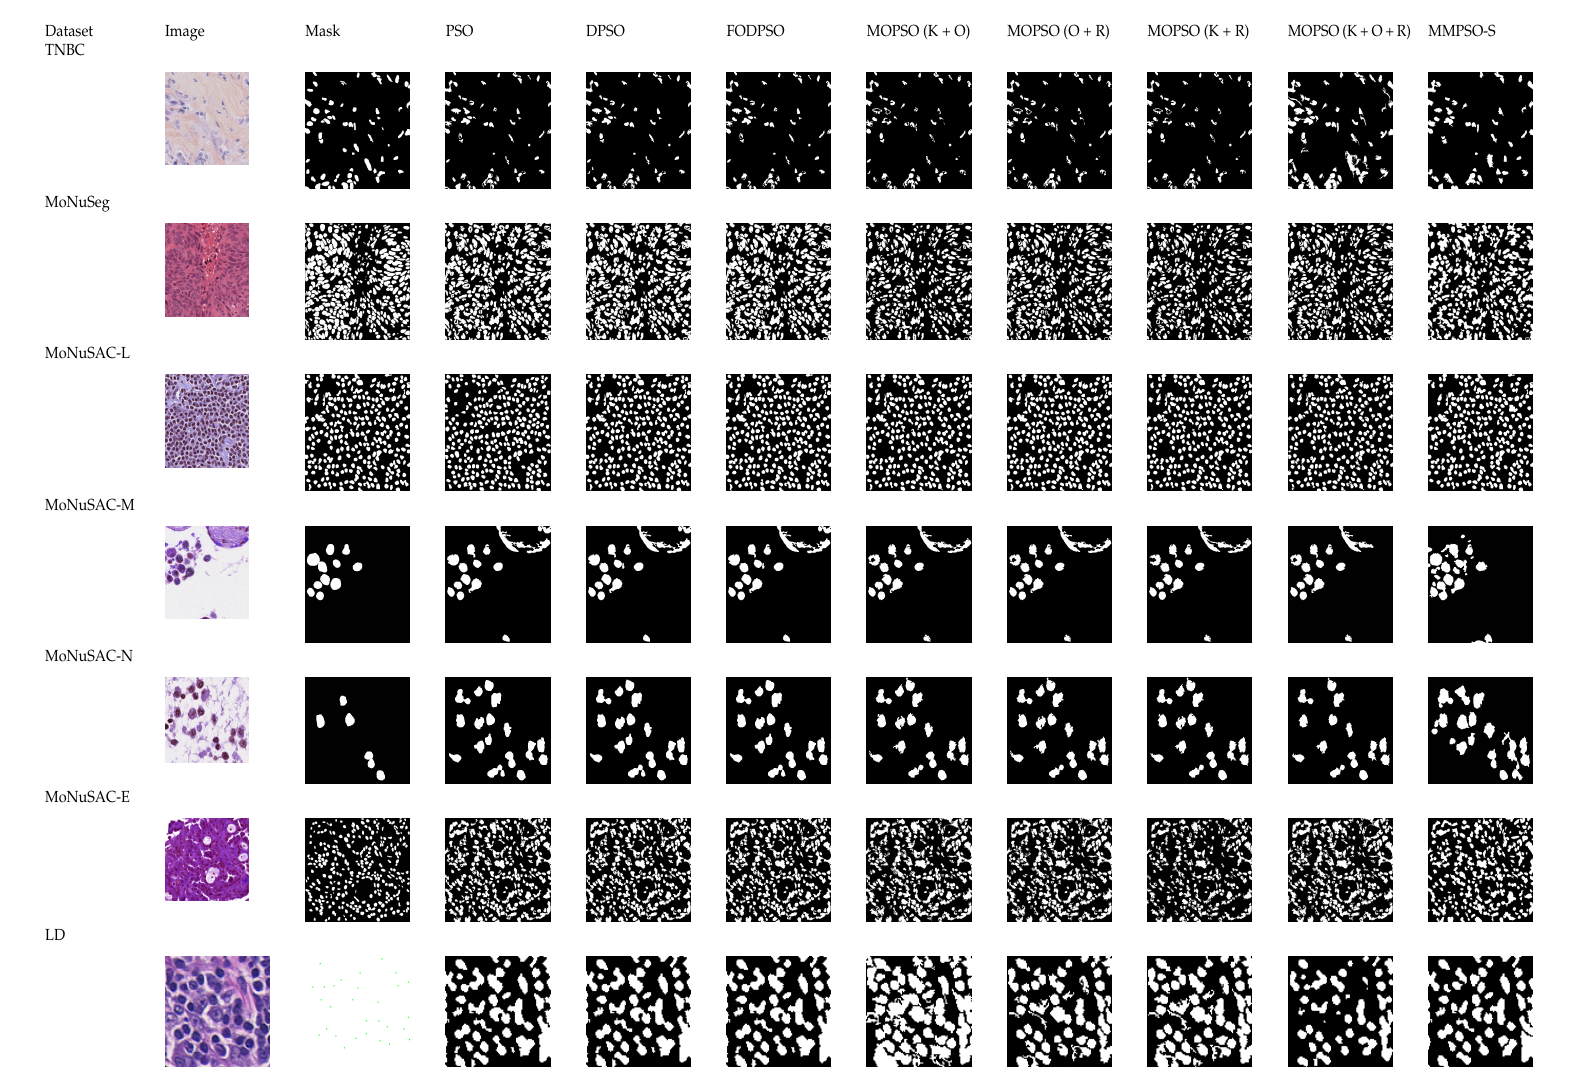
Figure 7. Final segmentation map of one sample image from